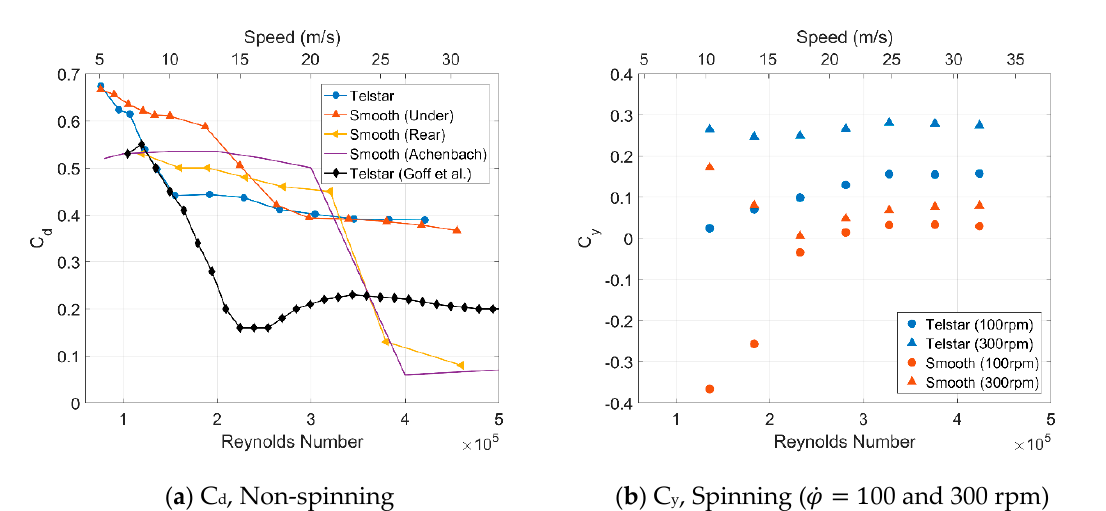
Figure 2. Time-averaged force coefficients against airspeed.